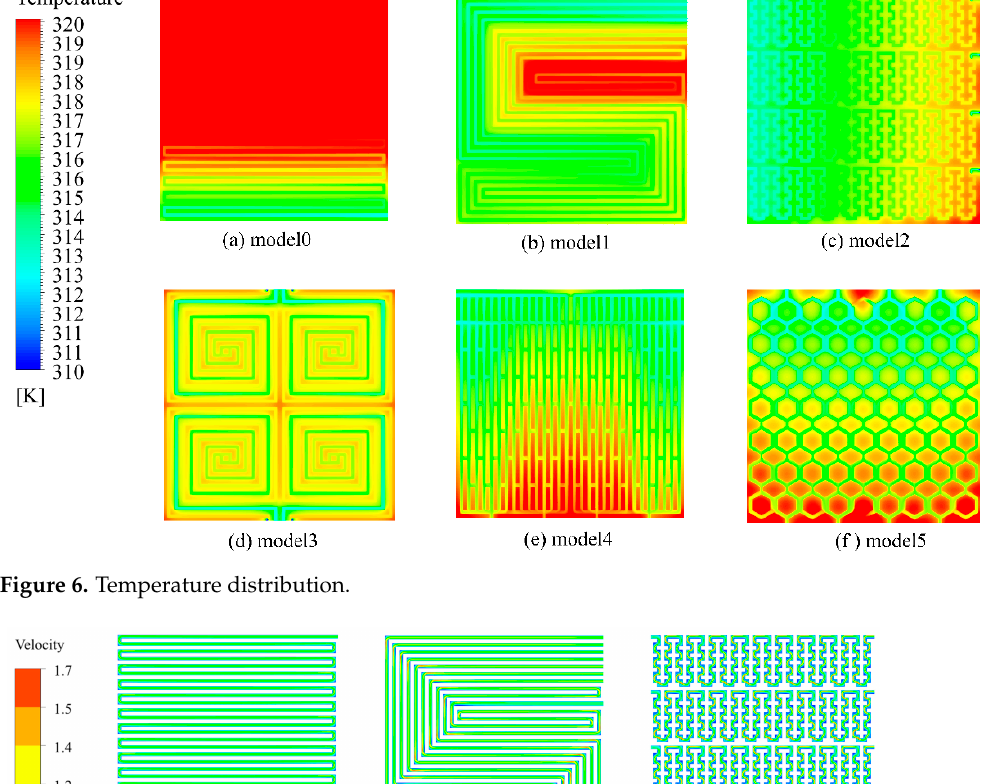
Figure 6. Temperature distribution.